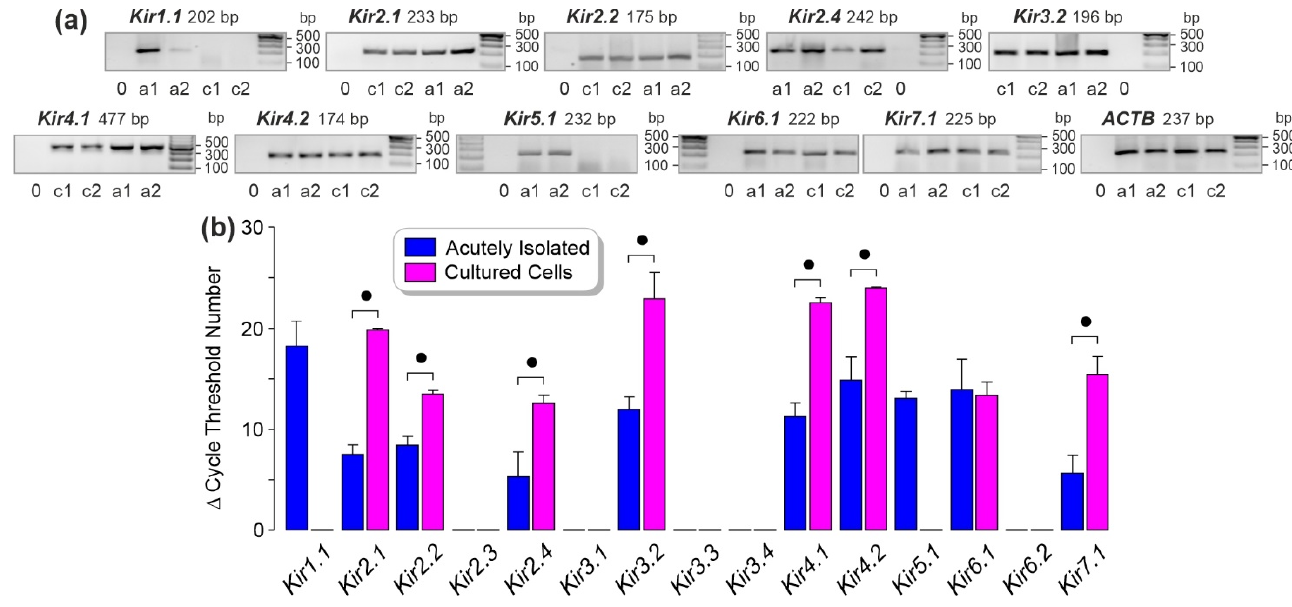
Figure 1. Kir channel gene expression in human RPE cells. ( a ) Agarose gel electrophoresis performed with products of acutely isolated (a) and cultured cells (c) from different post-mortem donors. 0, negative control carried out by the addition of double-distilled water instead of cDNA as a template. The level of β -actin ( ACTB ) mRNA was used to normalize the Kir channel mRNA levels in real-time RT-PCR analysis. ( b ) Comparison of the expression levels of Kir channel genes in acutely isolated and cultured RPE cells. The data were evaluated by real-time RT-PCR. The bars show the cycle numbers at the threshold of transcript detection. Cells derived from 4 (cultured cells) to 6 eyes (acutely isolated cells) of different donors were used. Significant difference between acutely isolated and cultured cells: ● p < 0.05.